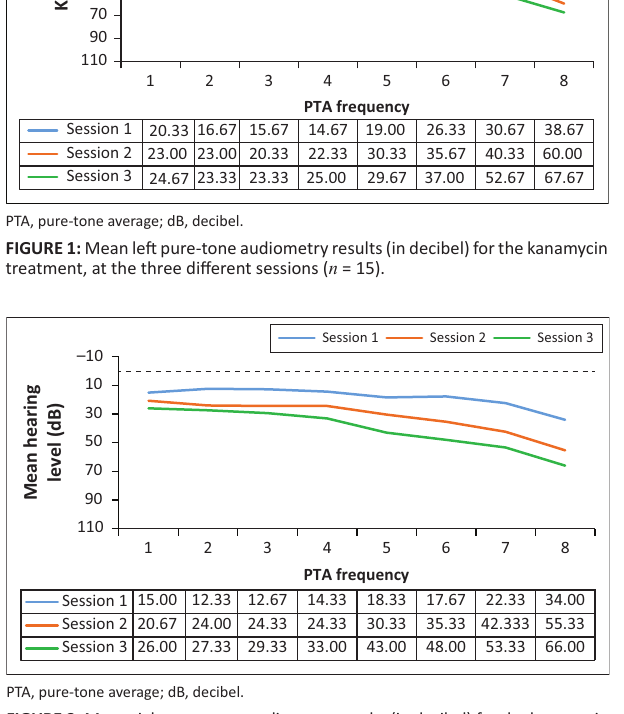
FIGURE 2: Mean right pure-tone audiometry results (in decibel) for the kanamycin treatment, at the three different sessions ( n = 15). TABLE 1: Results of analysis of variance for pure-tone audiometry for the kanamycin treatment, indicating level of significance.